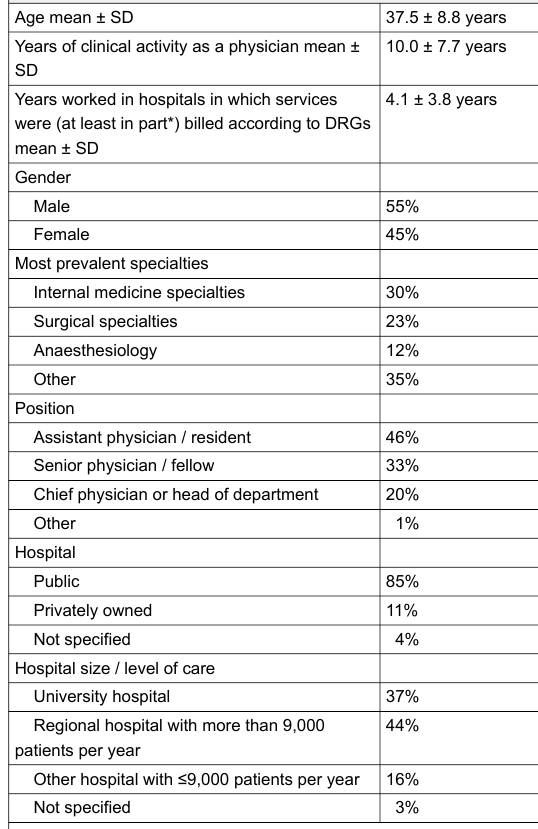
Table 1: Demographic data (n =